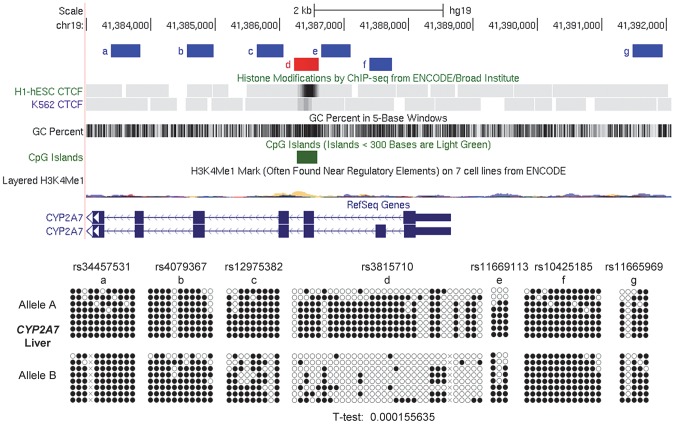
Local mapping of ASM in the CYP2A7 gene shows a discrete DMR that precisely overlaps a CTCF binding site.Bis-seq of heterozygous liver samples for multiple CYP2A7 amplicons shows ASM localized to a roughly 400 bp region (chr19: 41,386,227–41,386,613) spanning a CGI and a CTCF binding site in exon 2. ASM was evaluated visually and by a T-test on the percent methylation of individual clones, comparing the sets of clones for the two alleles.